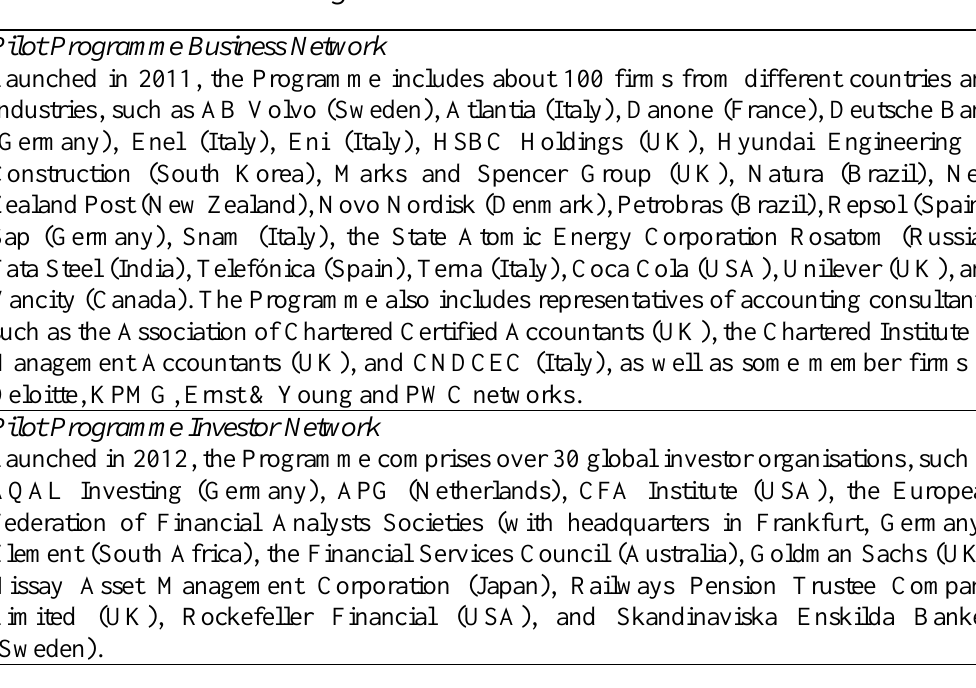
Table 2: The IIRC Pilot Programmes Pilot Programme Business